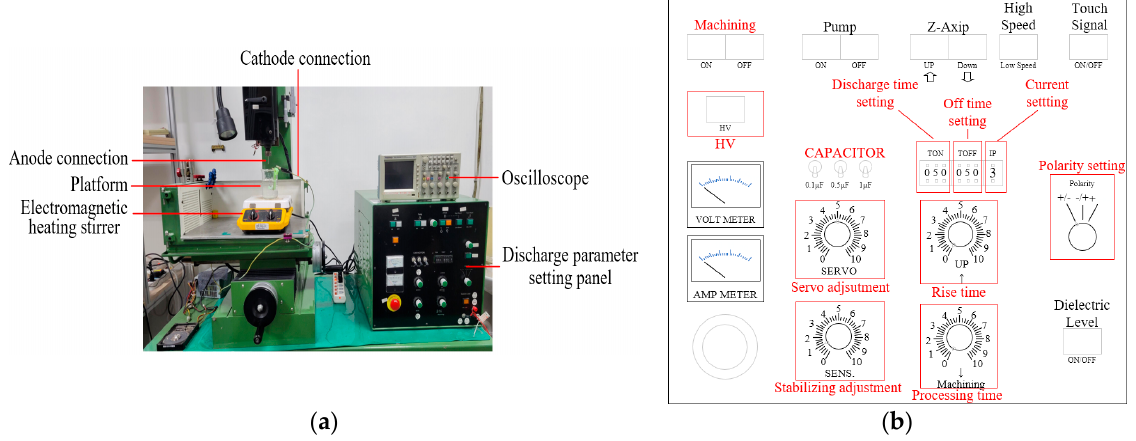
Figure 2. ( a ) Picture of EDM. ( b ) Discharge parameter setting panel.